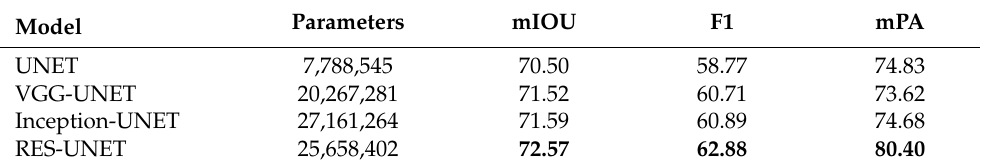
Table 2. Comparison of different UNET backbones on validation set. Best results are in bold.